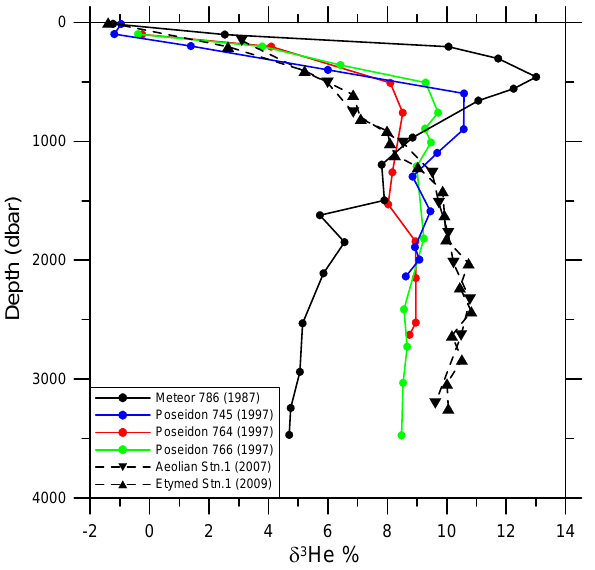
Fig. 2. δ 3 He versus depth in 1987 (M ETEOR cruise 5/6), 1997 (P OSEIDON cruise 234) and 2007/2009 (A EOLIAN 07 and E T - YMED ). For cruises see Table 1 and for station positions see Fig. 1. δ 3 He is defined as the relative deviation (%) from the atmospheric 3 He/ 4 He ratio. Due to different solubility of the two isotopes (cf. Sect. 1), δ 3 He has surface values near − 1 . 6%.